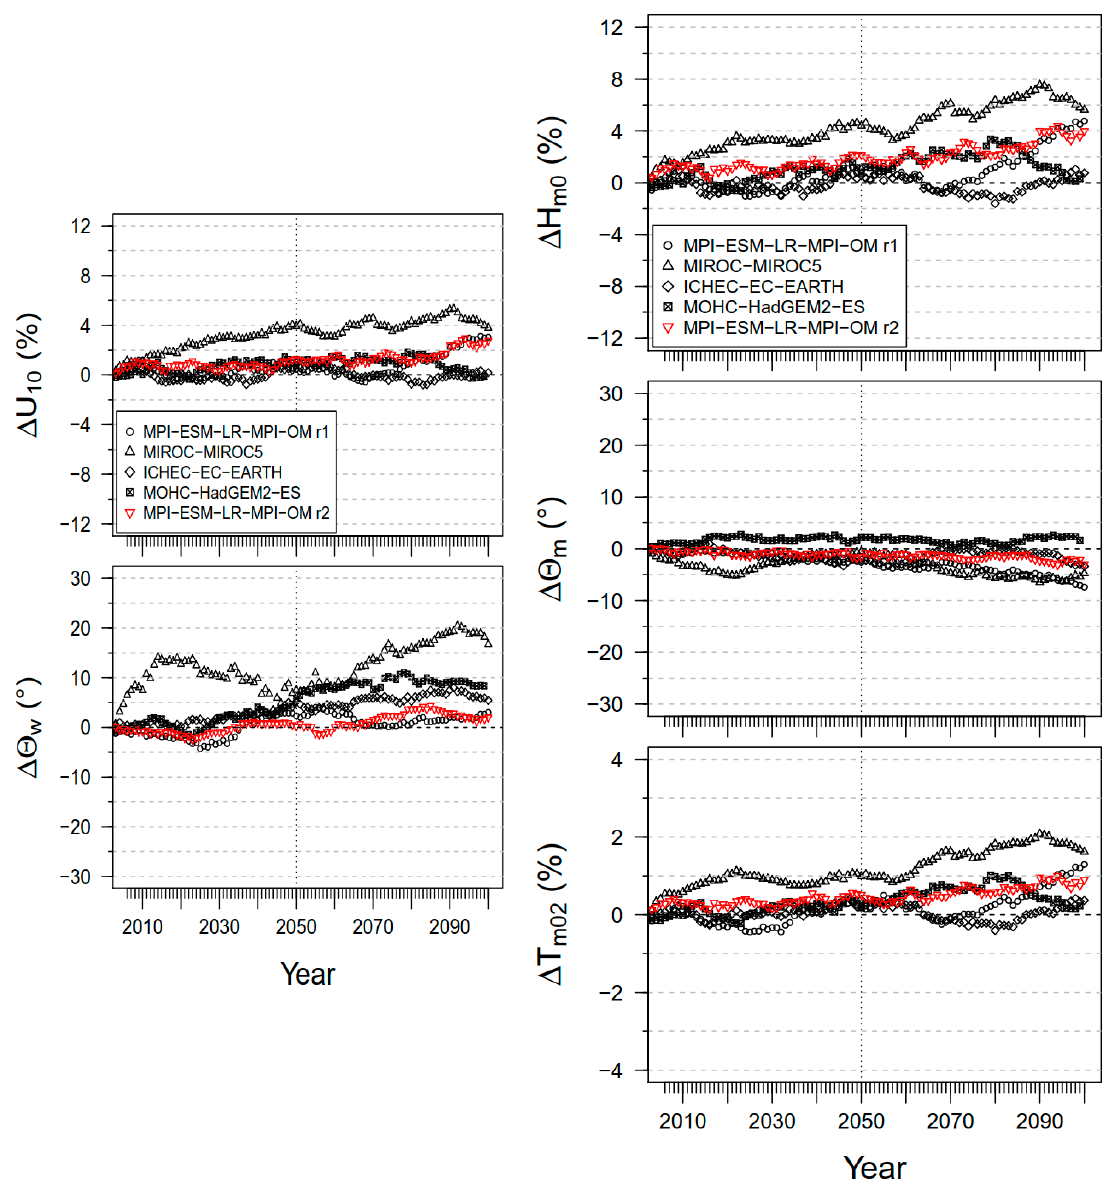
Figure 2. 30-year running mean of the future relative/absolute changes Δ (%)/ Δ (°) of the mean wind speed U 10 , wind direction Θ w ( left ) and significant wave height H m0 , mean wave period T m02 , mean wave direction Θ m ( right ) compared to the reference period 1971–2000 and for the ensemble members of the forcing scenario RCP8.5 (see Table 1) near “Rostock-Warnemünde”.